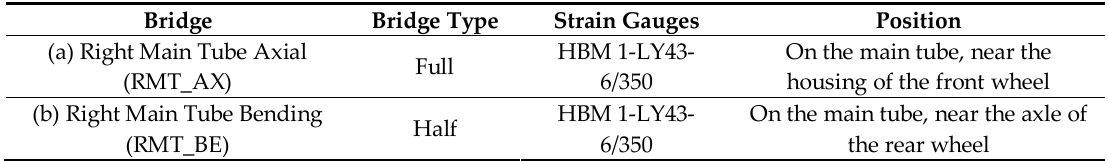
Figure 2. Name, position and sign convention of the s. g. bridges: ( a ) RMT_AX; ( b ) RMT_BE. Table 1. Details of the Wheatstone